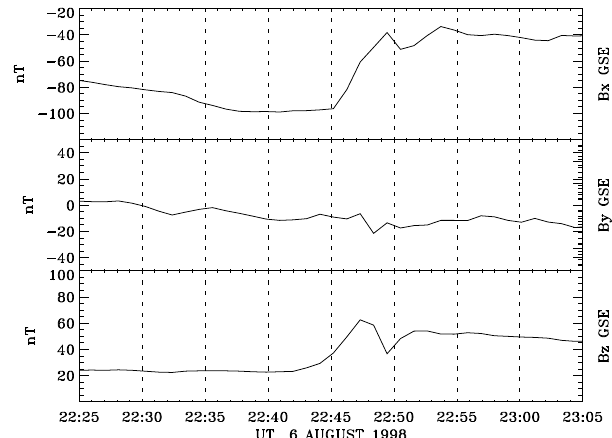
Fig. 3. Magnetic field data from the Geotail satellite which was situated at ( − 9, 0.5, 0.7 R E